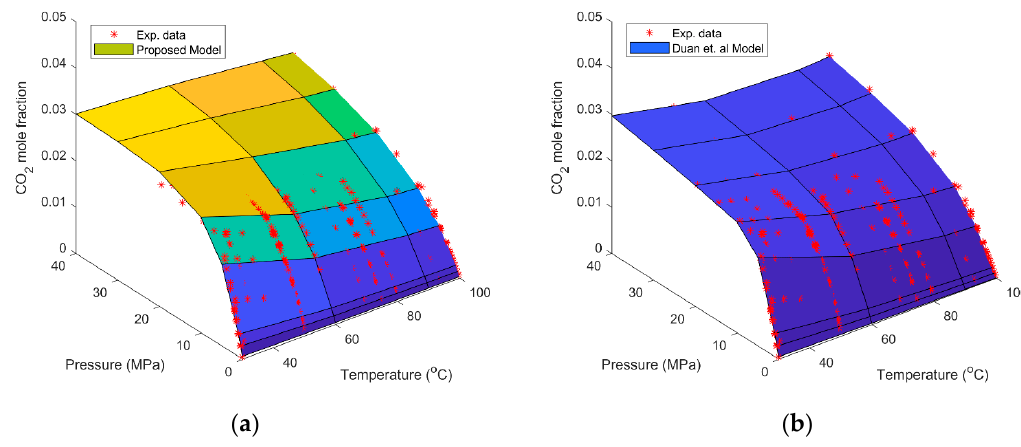
Figure 6. Evaluation of pure CO 2 solubility with experimental data and other models (( a ): Duan et al.